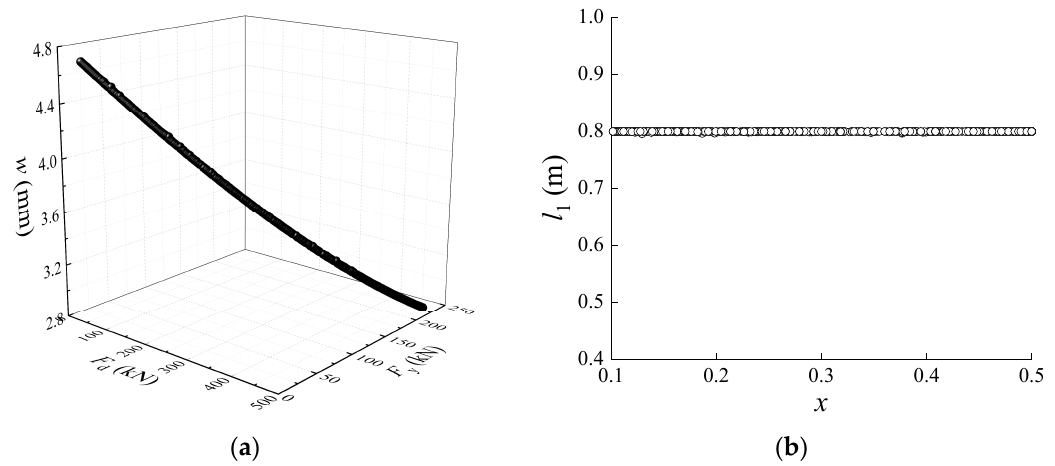
Figure 17. The plotted results of the multi-objective optimization. ( a ) Pareto optimal solution; ( b ) optimization variable value.